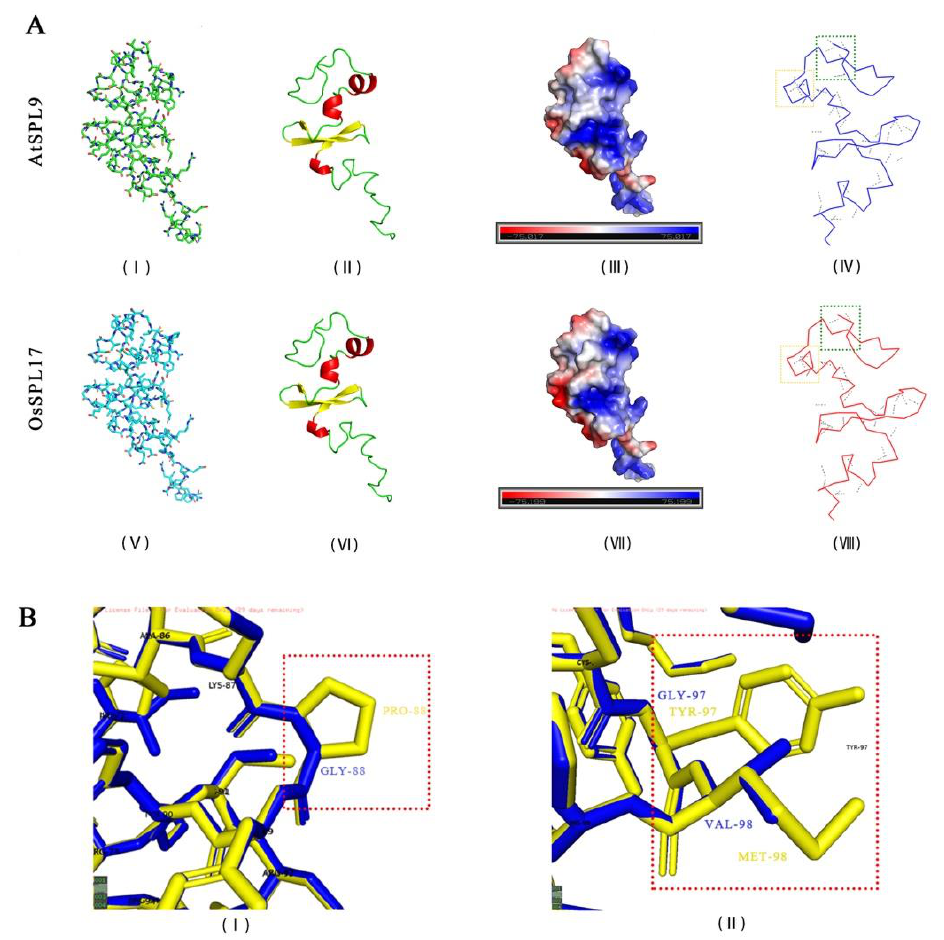
Figure 5. Comparative analysis of AtSPL9 and OsSPL17 protein structures. ( A ) The stick structure ( A ( I , V )), secondary structure ( A ( II , VI )), surface electrostatic potential ( A ( III , VII )) and hydrogen bonding structure ( A ( IV , VIII )) of AtSPL9 and OsSPL17 proteins. ( B ) Differences in amino acid composition and protein structure between OsSPL17 and AtSPL9. In ( A ( II , VI )), the red part indicates the α -helix and the yellow part indicates the β -fold. In ( A ( IV , VIII )), the gray dashed lines indicate hydrogen bonds. In ( B ), the yellow and blue structures indicate the amino acid arrangement of AtSPL9 and OsSPL17, respectively. PRO: Proline. GLY: Glycine. TYR: Tyrosine. MET: Methionine. VAL: Valine.